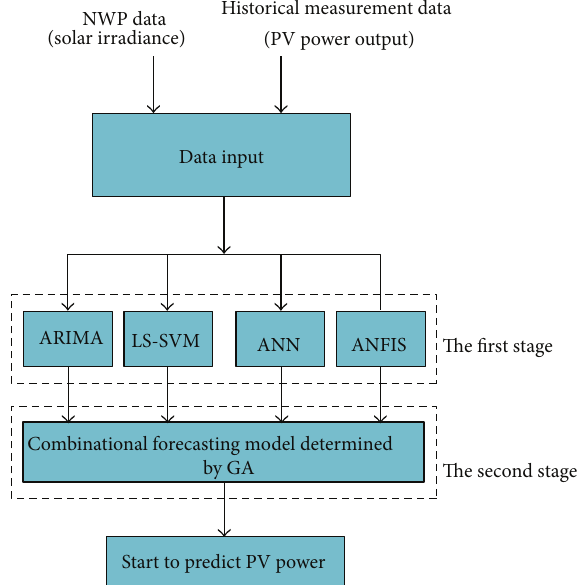
Figure 7: The complete model block diagram for the proposed forecasting model.